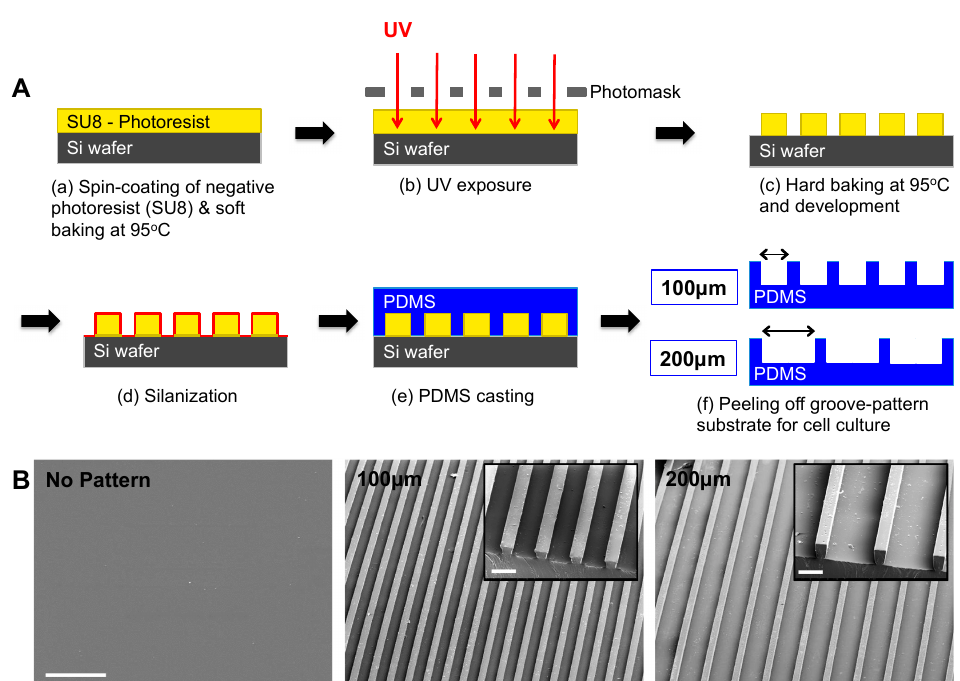
Figure 1. Fabrication and characterization of micropatterned PDMS cell culture substrates. ( A ) Schematic illustration of standard soft lithography procedures for fabrication of micropatterned PDMS cell culture substrates. ( B ) Surface characterization of various PDMS cell culture substrates by SEM. SEM images show non-patterned (left) and micropatterned substrates (100 μ m grooves— middle and 200 μ m grooves—right). Corresponding higher-magnification SEM images are also presented in the insets. Scale bars = 500 μ m and 100 μ m (inset). Polymers 2017 , 9 , 580